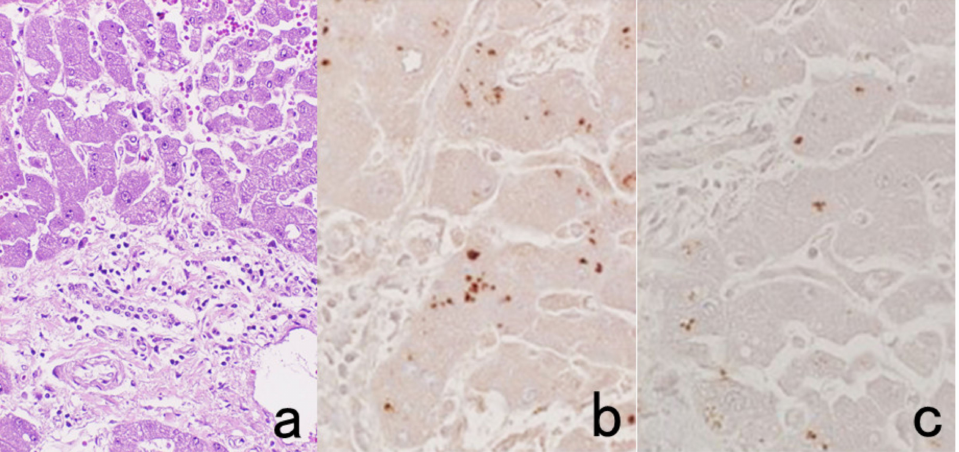
Figure 10. Demonstration of HCV antigens in an archival liver specimen of chronic hepatitis after HIER. ( a ): H&E, ( b ): monoclonal antibody against the NS3 region of HCV and ( c ): monoclonal antibody against the E1 region. Dot-like immunoreactivity of HCV antigens is seen in the cytoplasm of hepatocytes. The specimen was kept in formalin for 40